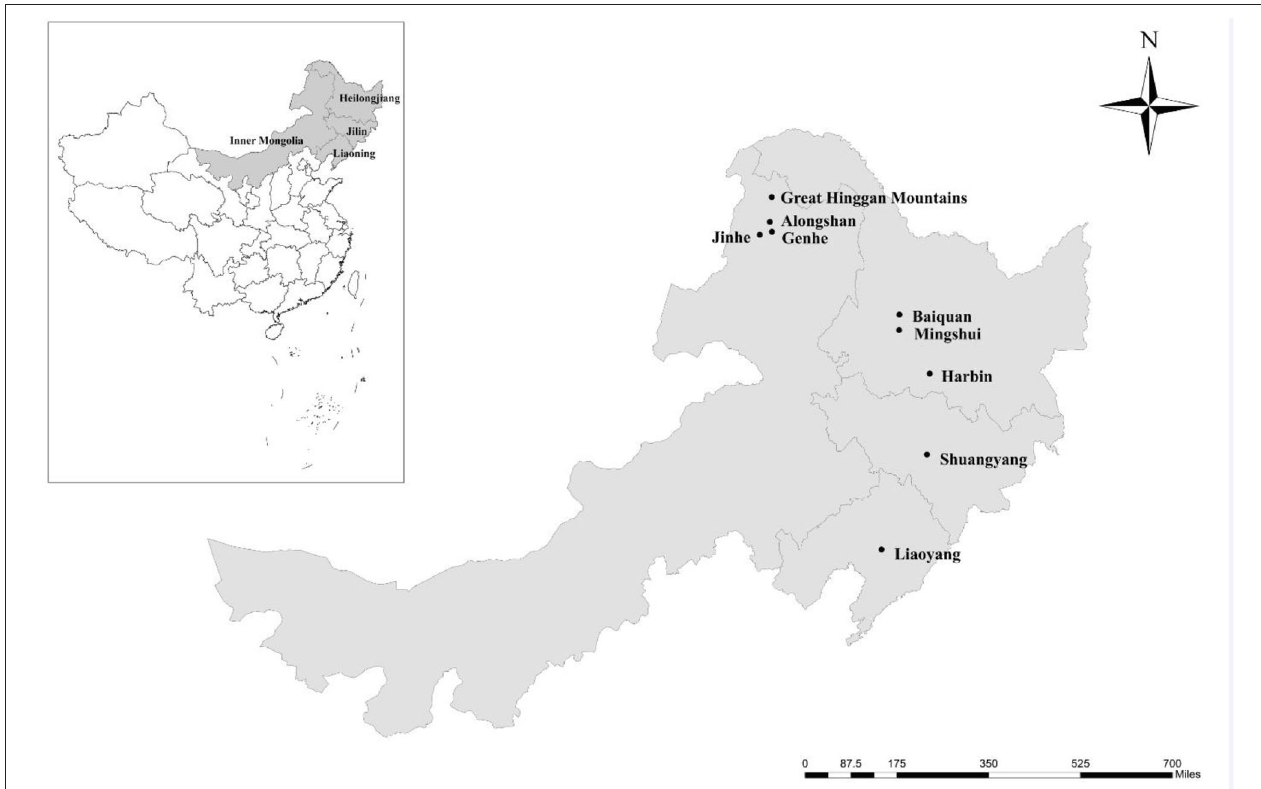
FIGURE 1 | Specific locations where samples were collected in this study. • Sampling